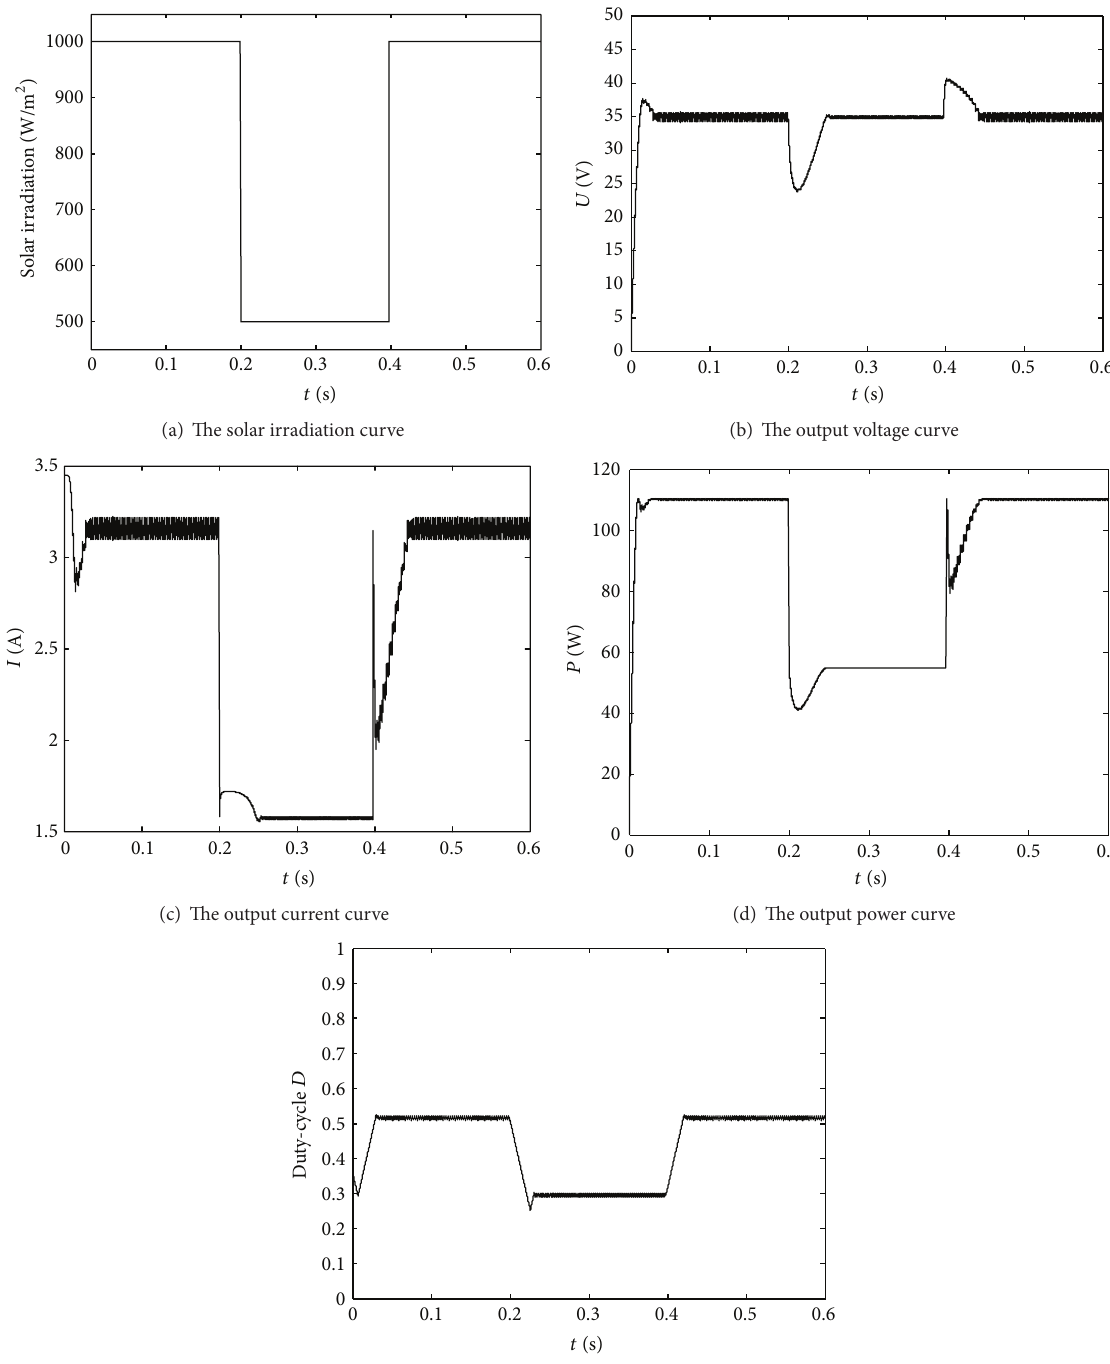
Figure 13: The classical P&O algorithm